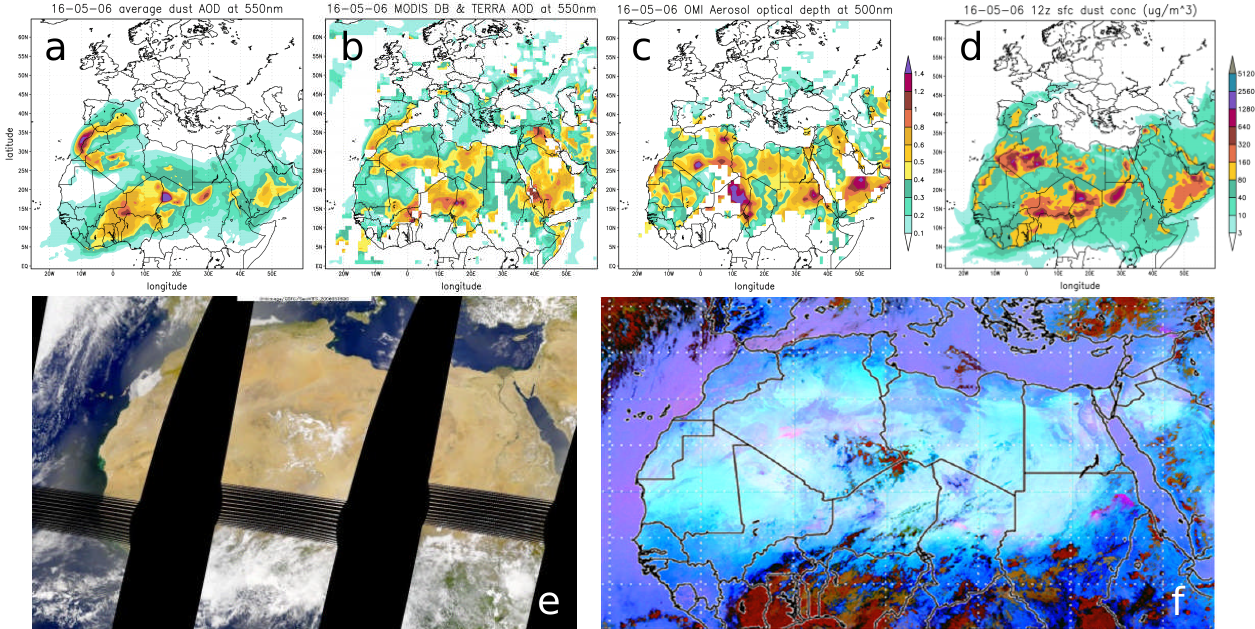
Fig. 2. Four hour average AOD from NMMB/BSC-Dust (a) , MODIS Deep Blue and Terra (b) , OMI AOD (c) , model derived surface dust concentration at 12:00UTC (d) , the SeaWiFS VIS image at 12:00UTC (e) , and the MSG dust image at 12:00UTC (f) on 16 May 2006 are displayed for the North African